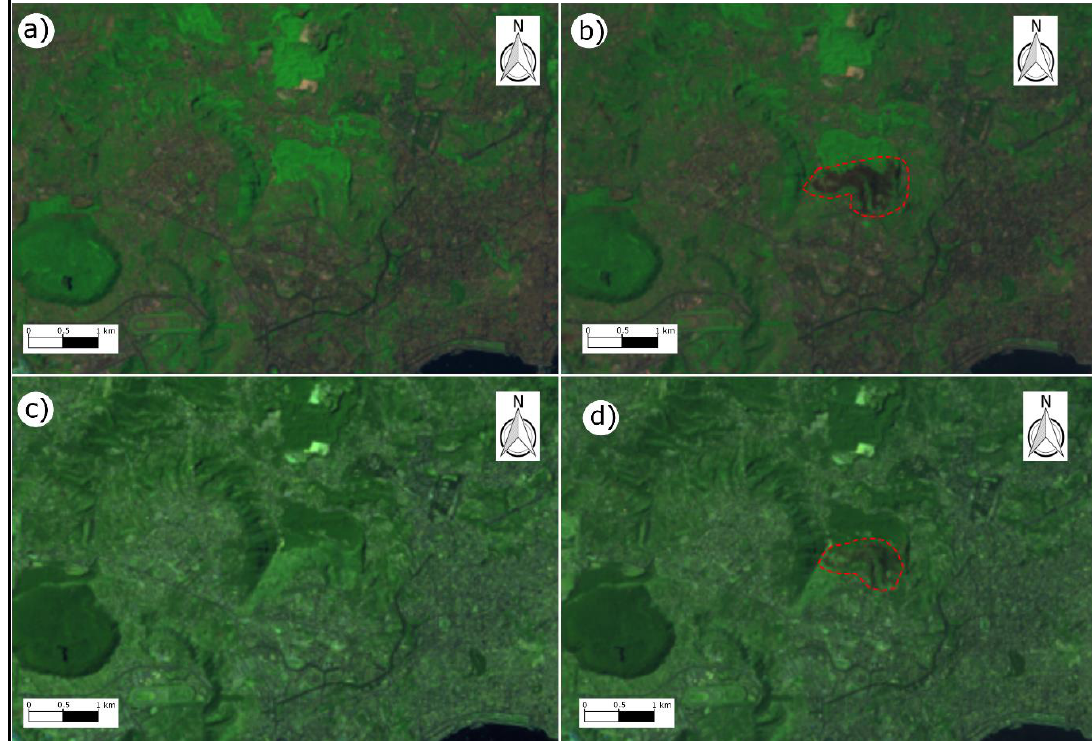
Figure 4. ( a , b ) Pre- and post-fire conditions visible with a band composition 7-4-2; ( c , d ) pre- and post-fire conditions visible with a 7-5-3 band composition. In ( b , d ), red polygons are shown, which highlight where the wildfire occurred. Note that with the band composition 7-4-2, the identification of the burnt areas is more and evident than with the 7-5-3 band composition. Table 3. Bands chosen for the composition of Sentinel-2 images.